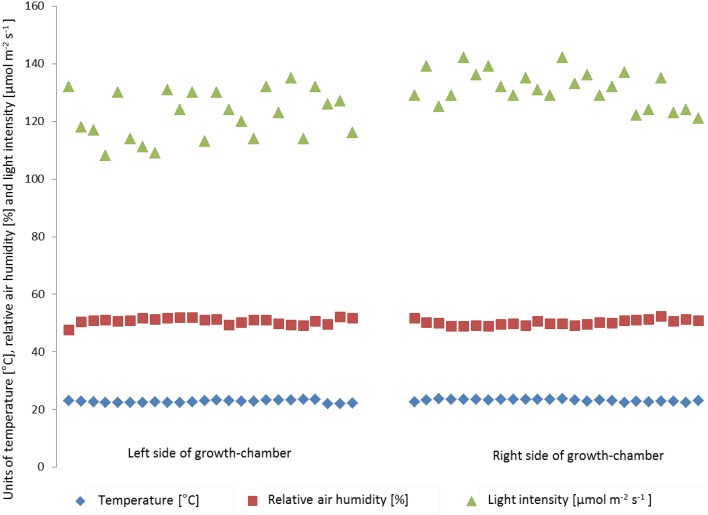
Variation in air temperature (blue), relative air humidity (red) and light intensity (green) within the HT phenotyping phytochamber. Air temperature and relative air humidity are stable within the phytochamber (no side effects), whereas the right side of the phytochamber shows a clear trend toward higher light intensity compared to the left side.